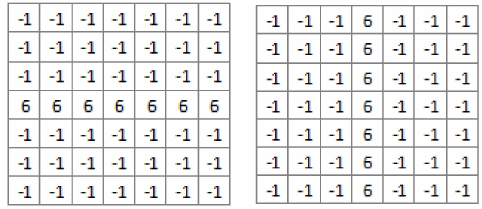
Figure 6. Filter kernels to highlight image areas that correspond to elevations of the function i ( x , y ).